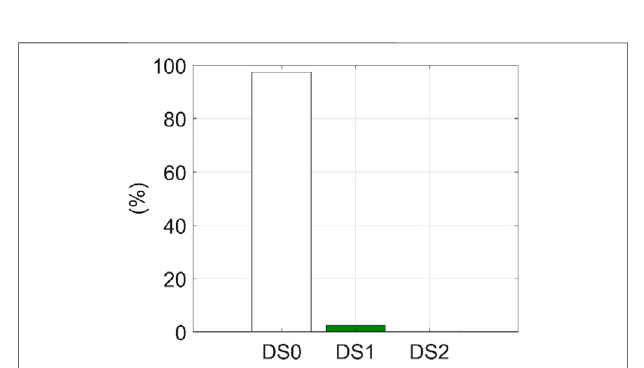
FIGURE 10 | Distribution of damage in